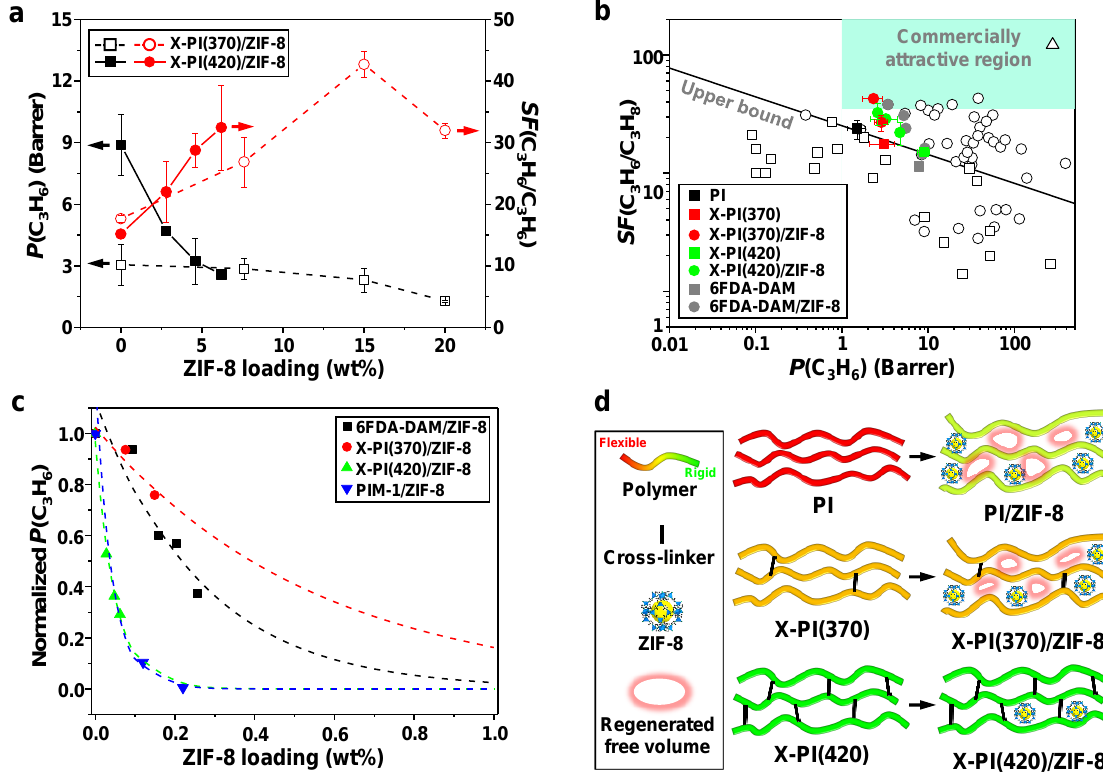
Figure 8. ( a ) C 3 H 6 permeability ( P ) and C3 separation factor ( SF ) of the X-PI/ZIF-8 MMMs as a function of ZIF-8 loadings in MMMs; ( b ) upper bound plot of the C3 separation performances of the X-PI/ZIF-8 MMMs in comparison with those of the reported polymers ( □ ) [36 – 41], MMMs ( ○ )[14,16,42 – 55], and ZIF-8 ( △ )[42]; ( c ) normalized C 3 H 6 permeabilities of in situ formed ZIF-8 containing MMMs as a function of ZIF-8 loadings; and ( d ) schematic illustrations of the free volume and chain flexibility changes before and after the PMMOF process. It is noted that the PI illustrated in ( d ) indicates 6FDA-DAM and that 6FDA-DAM:DABA (3:2) failed to produce PI/ZIF-8 MMMs (see Figure 4).